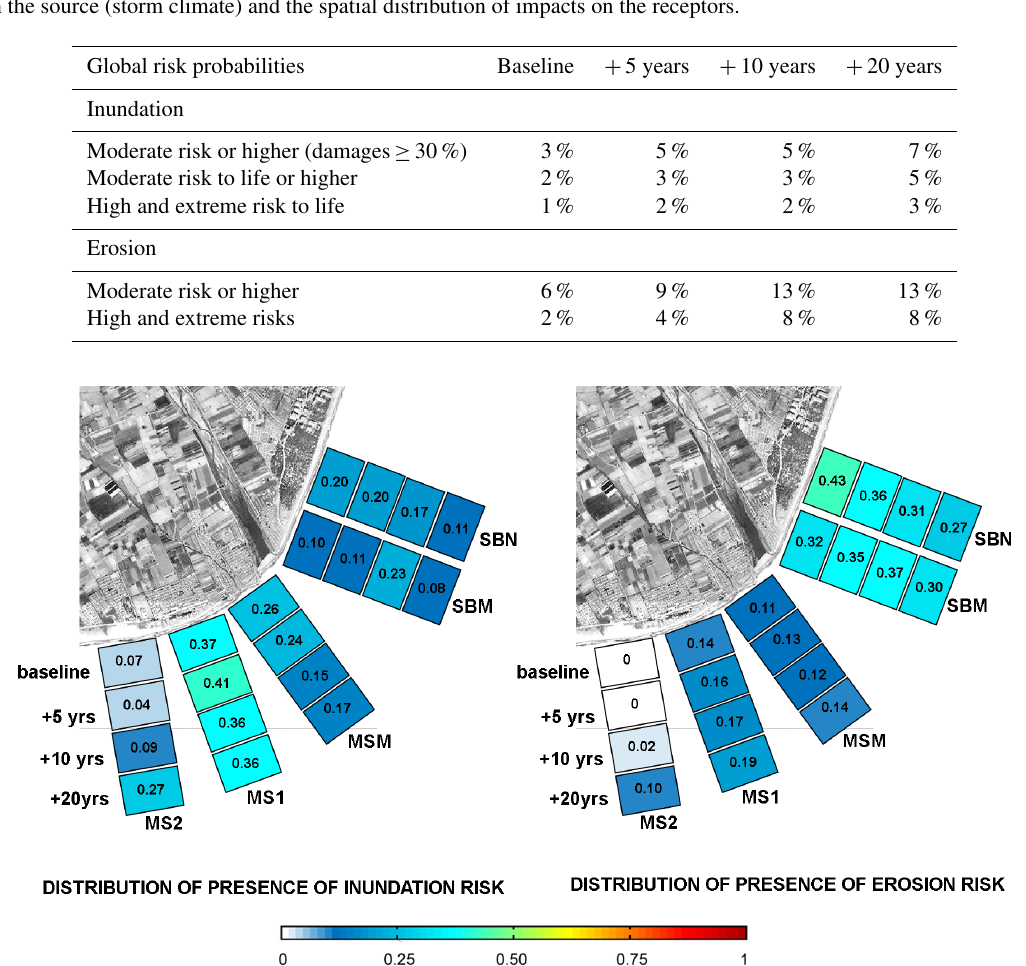
Figure 8. Distribution of risks (at any level) across the different sectors (see specific locations in Fig. 1). This shows the relative proportion of impacted receptors in the different areas, under the baseline morphology and the future + 5-, + 10-, and + 20-year scenarios. Orthophoto provided by Institud Cartogràgic I Geològic de Catalunay